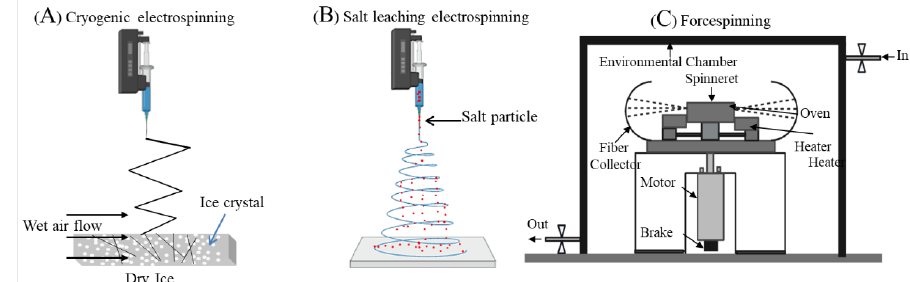
Figure 5. Different types of electrospinning fabrication setups ( A , B ). Forcespinning setup ( C